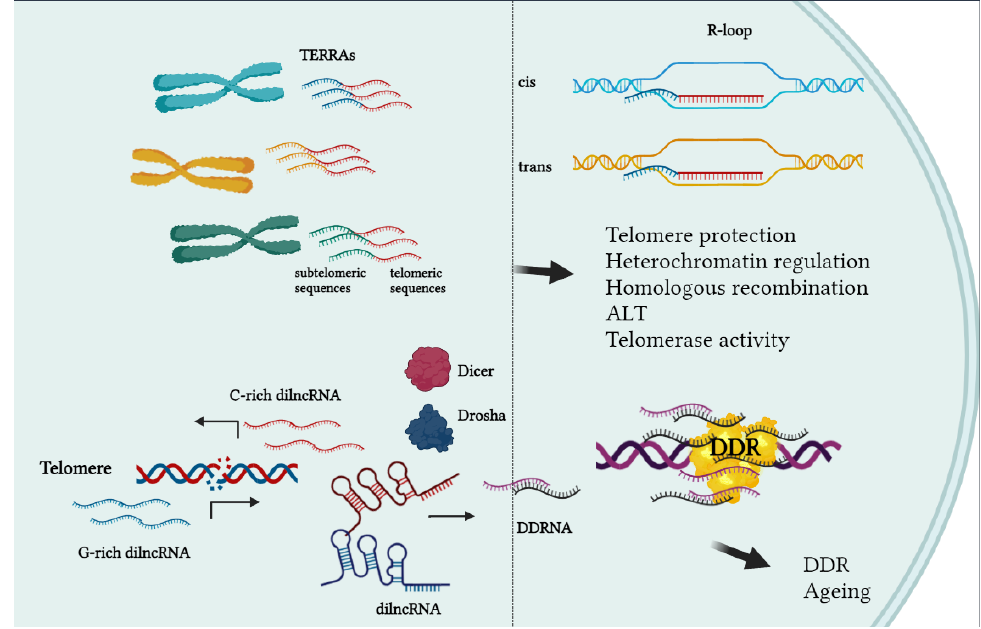
Figure 3. RNA transcription at telomeres. Telomeres are transcribed starting from subtelomeric regions toward telomere ends. They form DNA:RNA hybrids in cis or trans. TERRAs are involved in telomere protection, elongation and recombination. Telomere transcription is driven by DNA damage and leads to the formation of telomeric RNAs which boost DNA damage response. They are also transcribed by eroded telomeres during replicative senescence, which contain DDR markers and are involved in